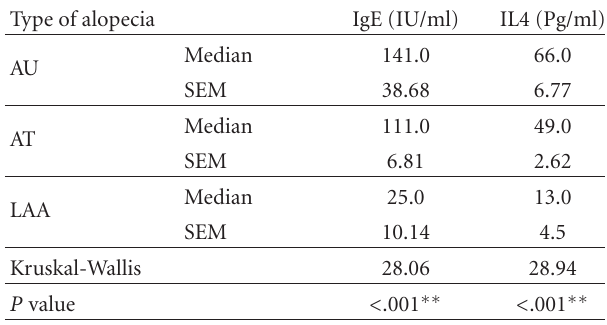
Table 2: Comparison between IgE and IL4 levels in di ff erent clinical forms of AA using Kruskal-Wallis test.